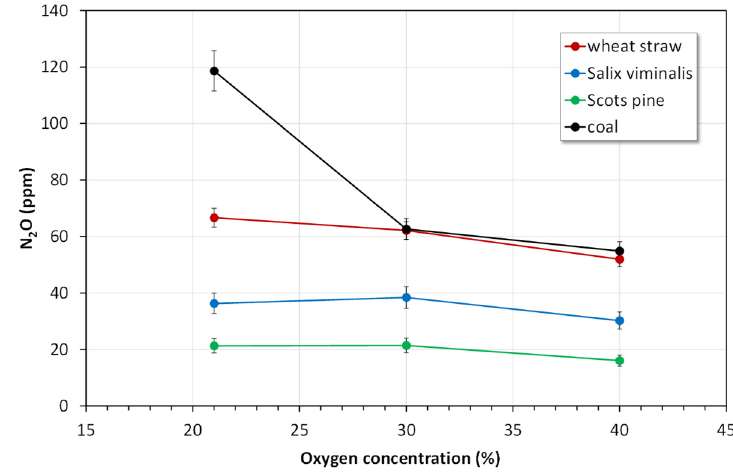
Figure 14. Effect of the oxygen concentration on the total emissions of N 2 O during oxy-combustion. Vertical bars represent standard deviation.